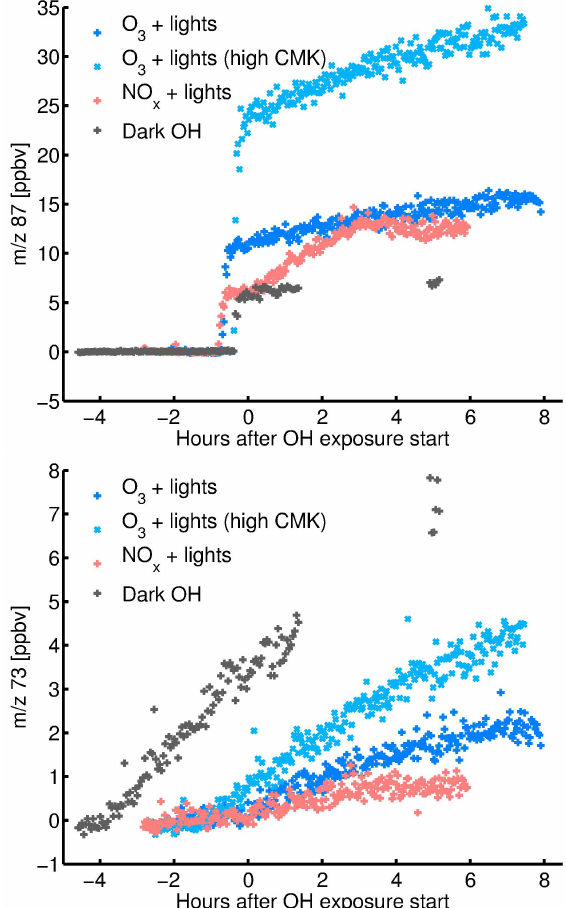
Fig. 6. Signals of the proton-transfer-reaction mass spectrometer (PTR-MS) for m/z 87 (top) and 73 (bottom). m/z 87 is the signal for succinic aldehyde and m/z 73 for